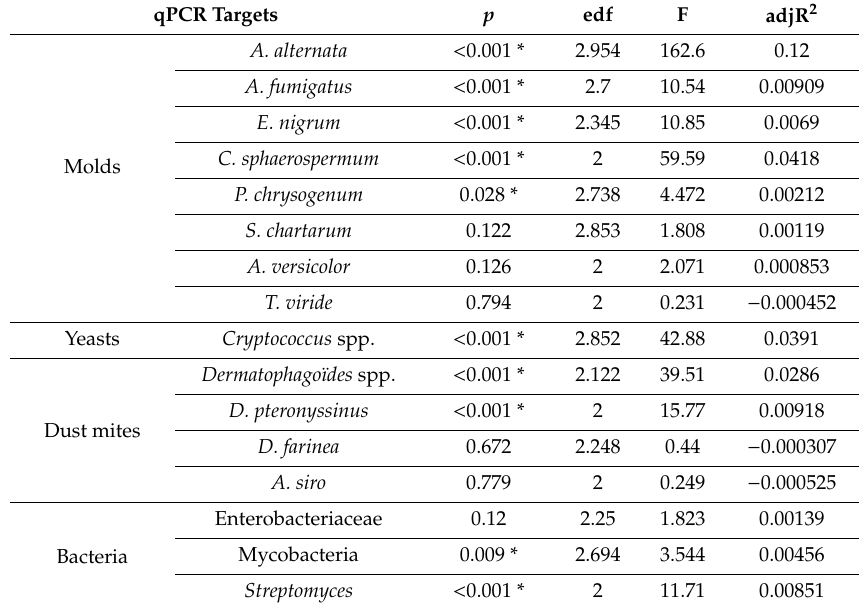
Figure 1. Redundancy analysis (RDA) plot showing target microorganisms and spatio-temporal (X and Y coordinates and months of samplings) distribution. Microorganisms are in black, coordinate variables in blue, and months in purple. Solid arrows indicate quantitative variables (X: longitude and Y: latitude). Months of samplings are qualitative variables and are represented without arrows. Table 3. Detailed output on the smoothers and parametric terms in the Generalized additive mixed models